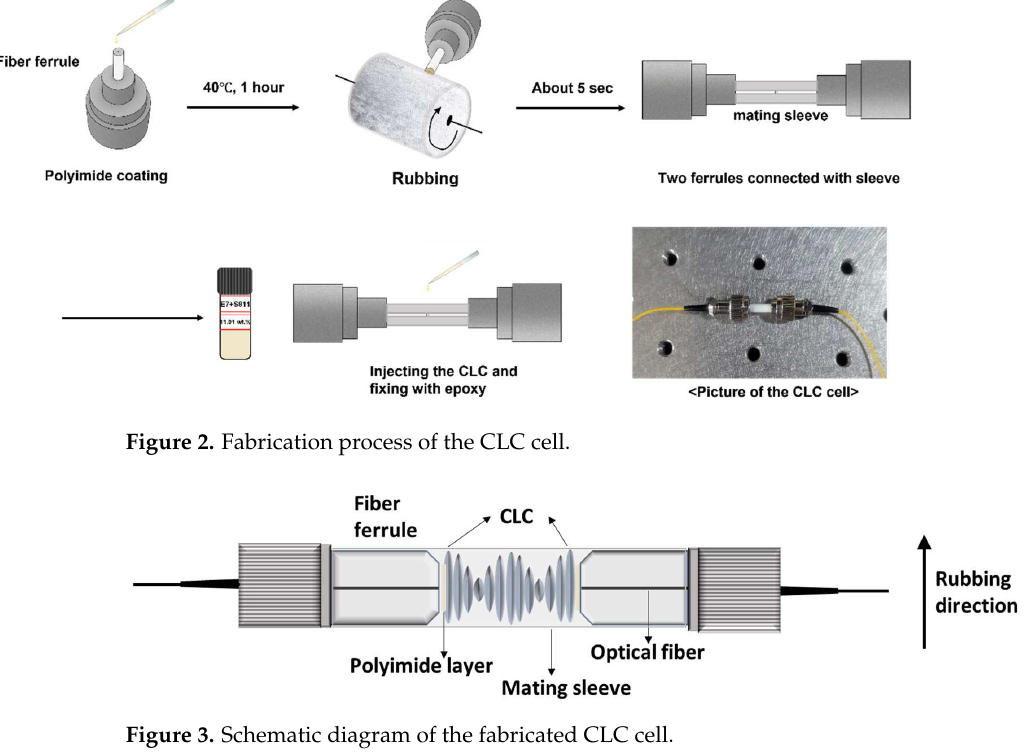
Figure 3. Schematic diagram of the fabricated CLC cell.